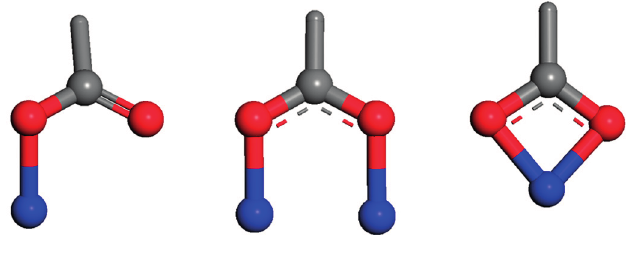
Figure 5. Possible surface complexes for carboxylate directly bound to surface metal atoms (blue) in monodentate, bridging, and bidentate